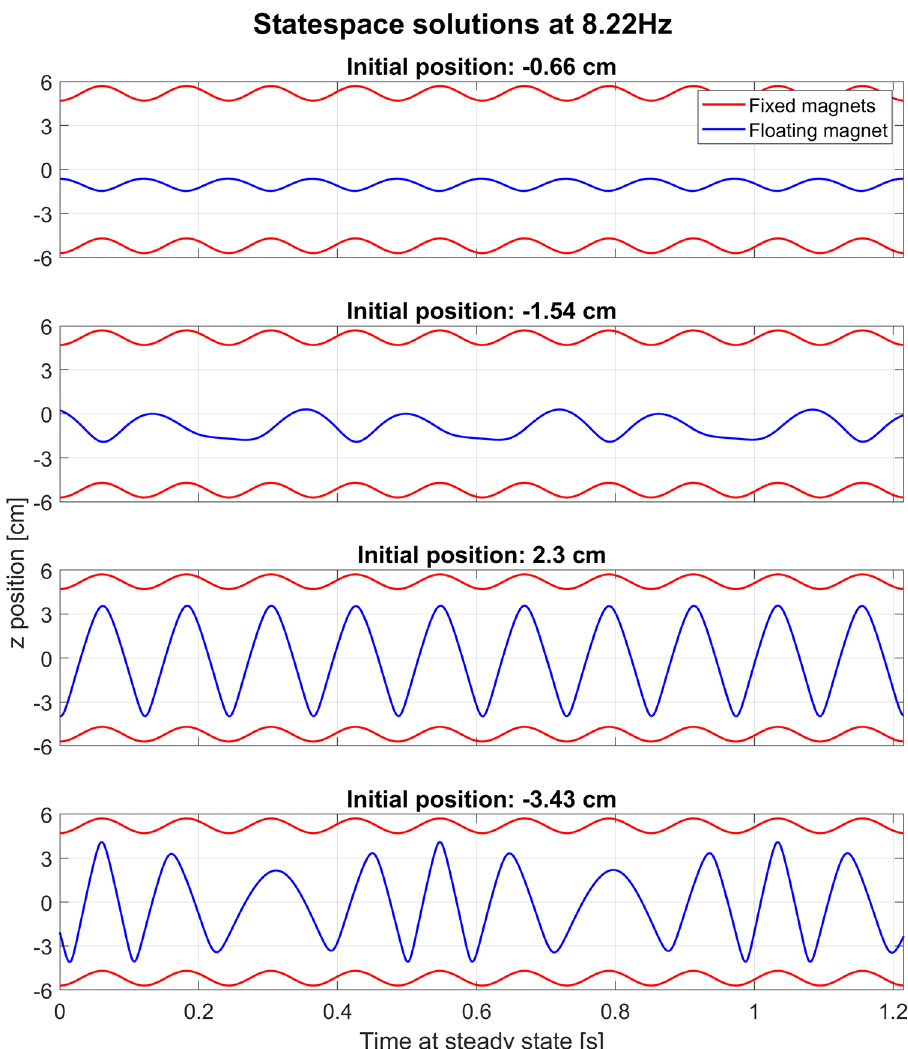
Figure 3. An illustration of the steady state behavior of the system with gravity at the same frequency of 8.22 Hz but different starting positions of the floating magnet as stated on the graphs. The initial velocity is − 7.09 cm/s in all cases. The movement is shown in a reference frame at rest, thus the fixed magnets also